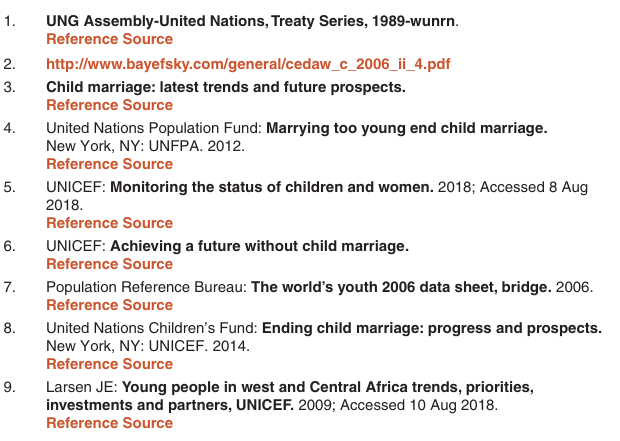
Figshare: Social and cultural factors perpetuating early mar- riage in rural Gambia: an exploratory mixed methods study. https://doi.org/10.6084/m9.figshare.10045979.v1 41 . This project contains responses to the questionnaires administered in this study.